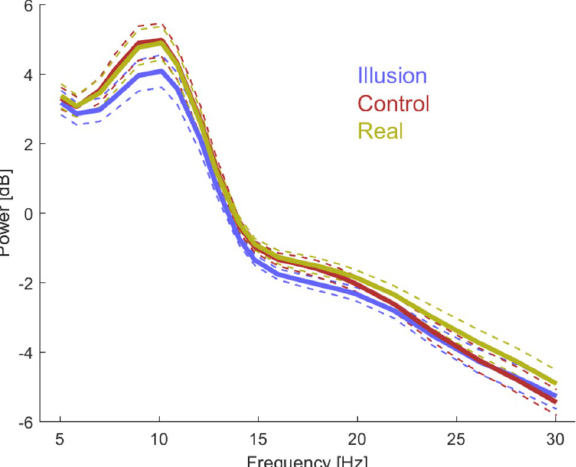
Fig 4. Overall spectral power for individual conditions. The graph illustrates the electrode and participant-averaged spectra for the Illusion, Incongruent (both averaged across hand positions) and the Real conditions. These suggest a reduced power during the Illusion condition compared to both control conditions in the alpha and beta bands. Thick lines indicate the mean and dashed lines the standard error across participants (n = 22).